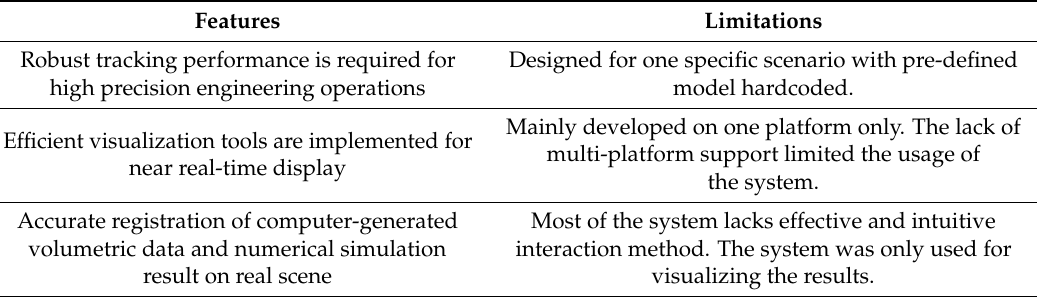
Table 6. Common characteristics and limitations of current AR-based engineering analysis and simulation